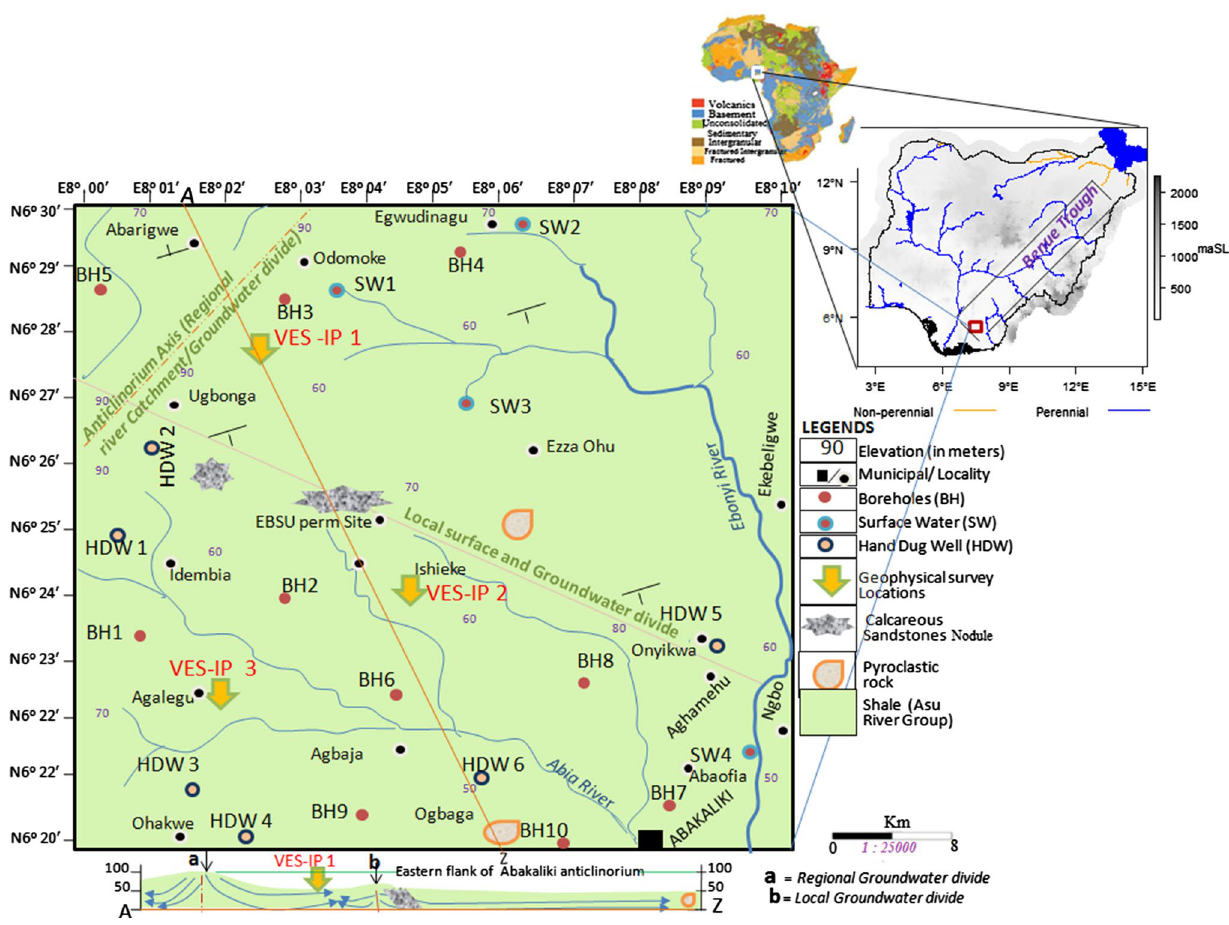
Fig. 1 Hydrogeological map of the studied